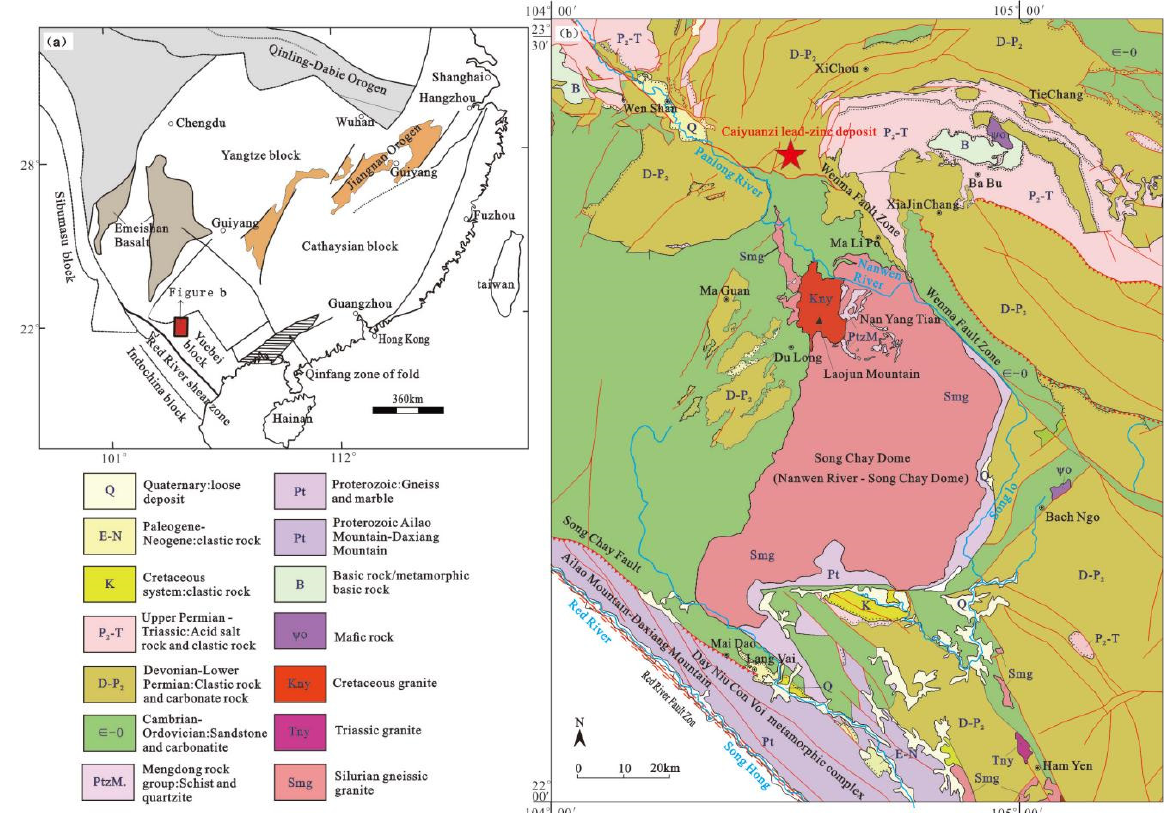
Figure 1. Geotectonic location map of the study area (( a ), modified according to [9]) and the regional geological map (( b ), quoted from